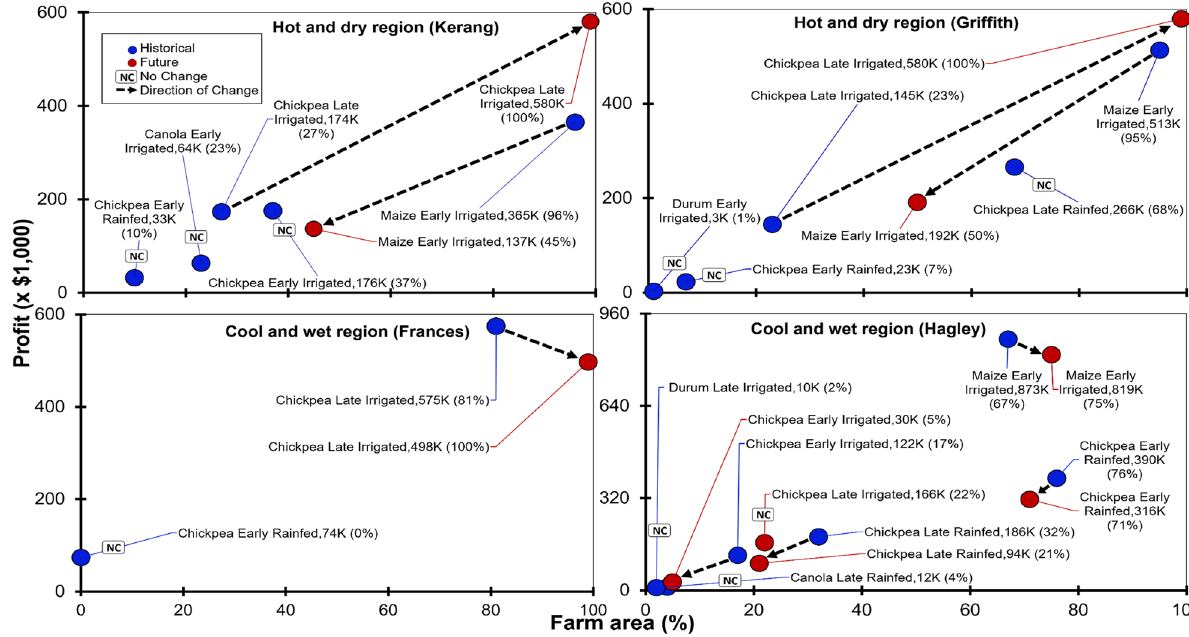
Figure 7. Change in farm profit and relative portion of whole farm area caused by climate change across irrigated grains regions of Australia under historical and future climates. Blue points indicate values for historical climates, red points denote future climates and arrows show shifts caused by climatic change. NC = no change between historical and future climates.